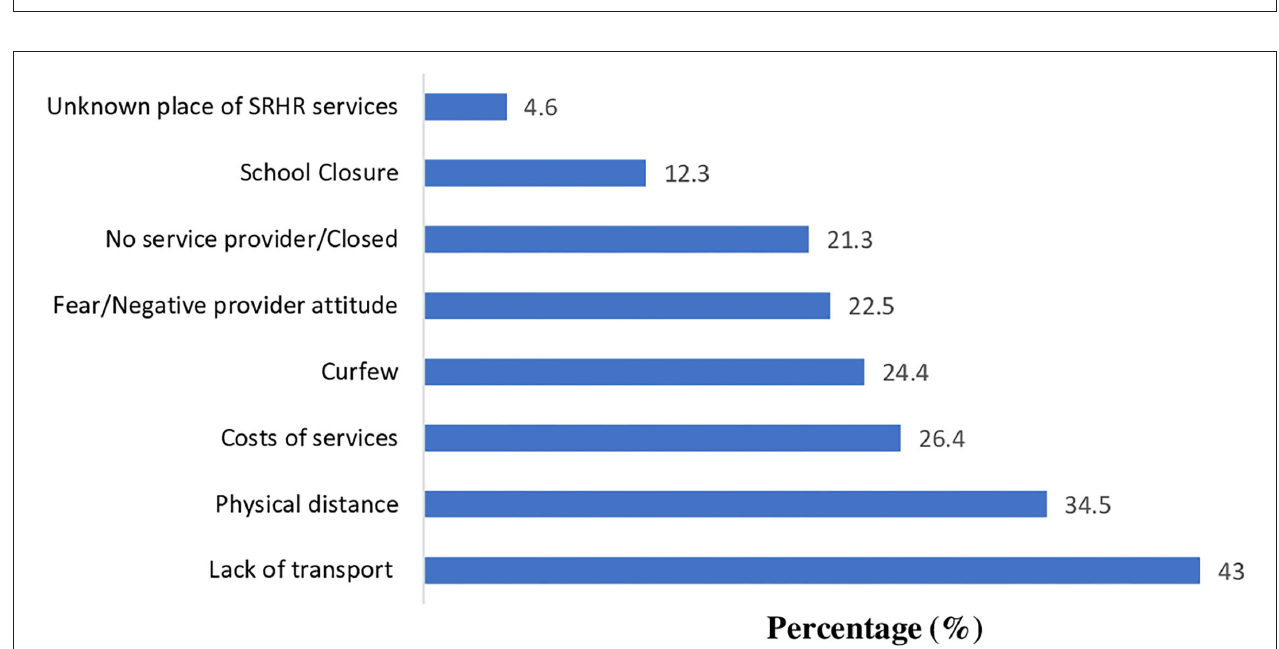
FIGURE 2 | Limiting factors to access sexual and reproductive health services and information among Ugandan youth during the COVID-19 lockdown.